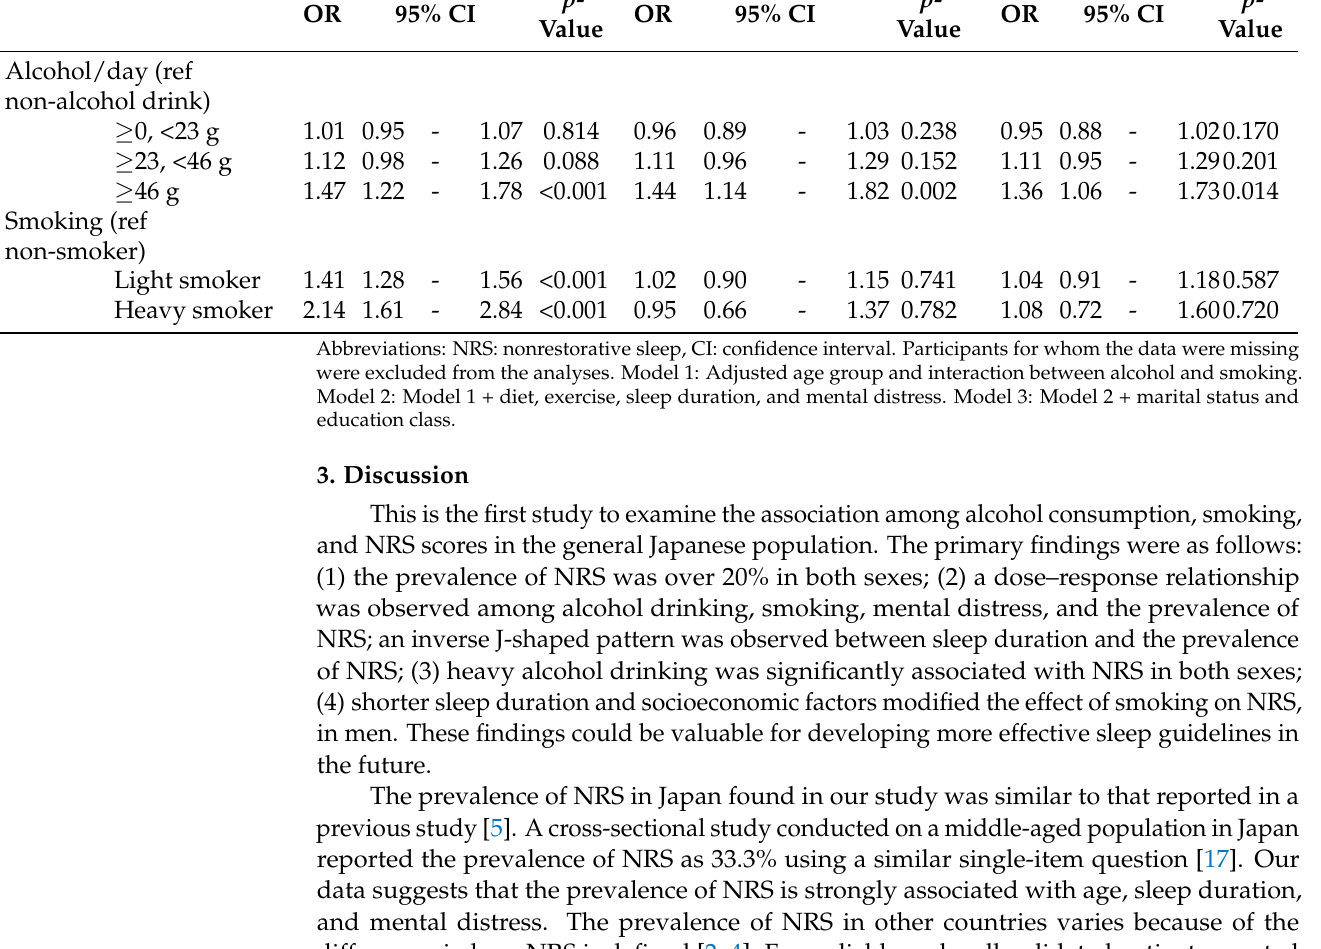
Table 4. Odds ratio of NRS for alcohol and smoking among women. Model 1 (N =